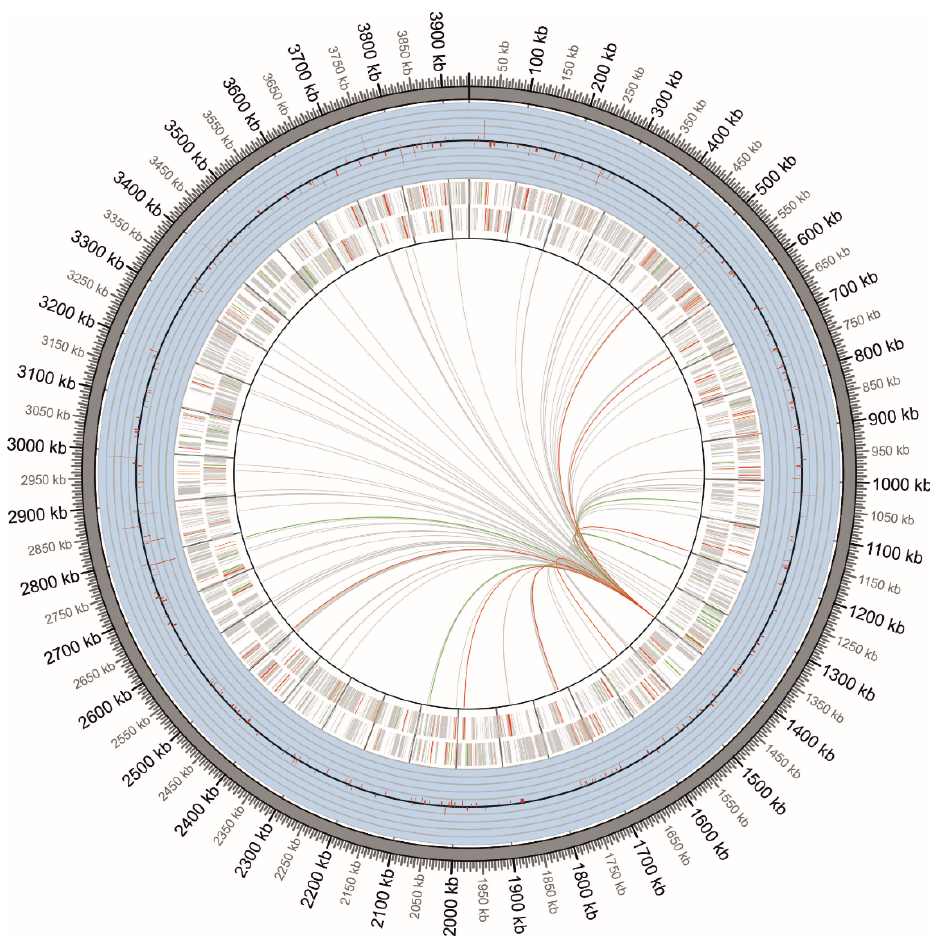
Figure 6. Circular representations of the G. diazotrophicus chromosome PAL5 showing transcriptome responses in the absence and presence of iron. On the chromosome, the outermost ring indicates the total transcriptome changes at the gene level, with the dark gray line representing the baseline and the light gray lines representing the fold-change changes. The two innermost rings indicate the genes in the forward and reverse chains. The green (up), red (down) and gray (non-expression) lines in the center indicate the regions likely to be regulated by the fur .